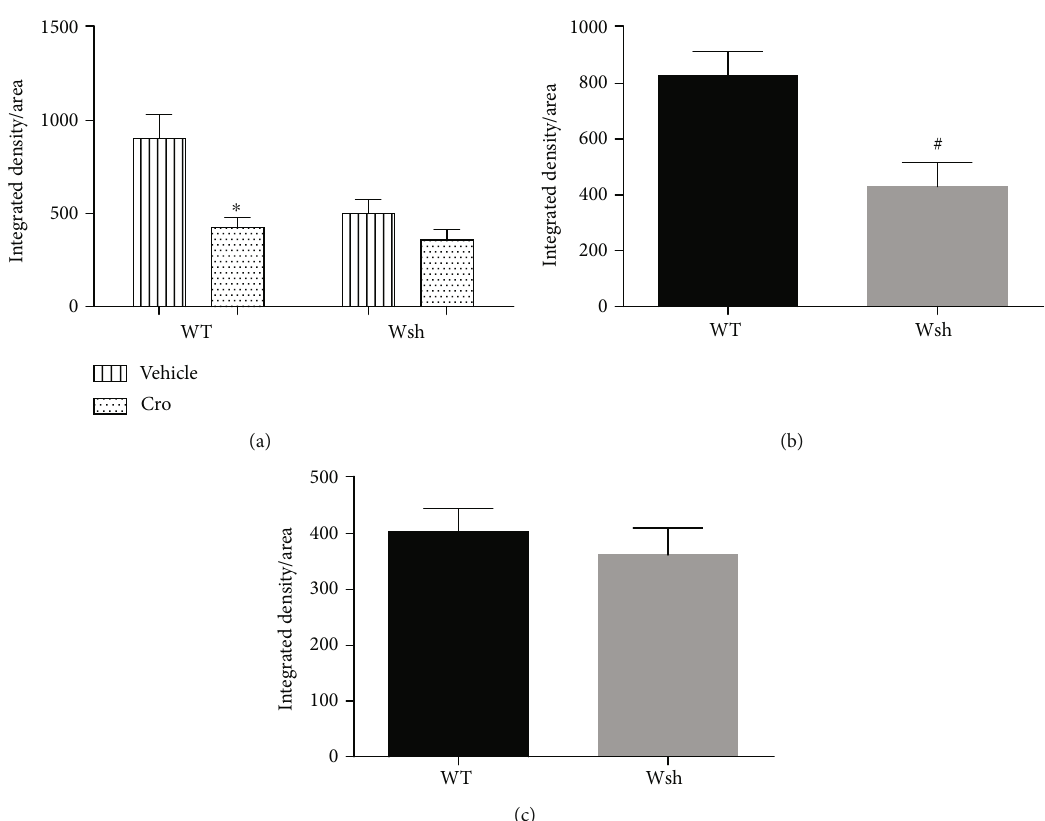
Figure 3: IgG leakage into the brain was inhibited by mast cell stabilization and de fi ciency. (a) The level of IgG in the hippocampus was detected by immunostaining in mice pretreated with cromolyn sodium versus vehicle. (b, c) In a separate experiments, IgG was measured at 1 day and 3 days after surgery. ∗ P < 0 : 05 versus WT vehicle. # P < 0 : 05 versus WT group. Data are presented as the mean ± SEM ( n = 5